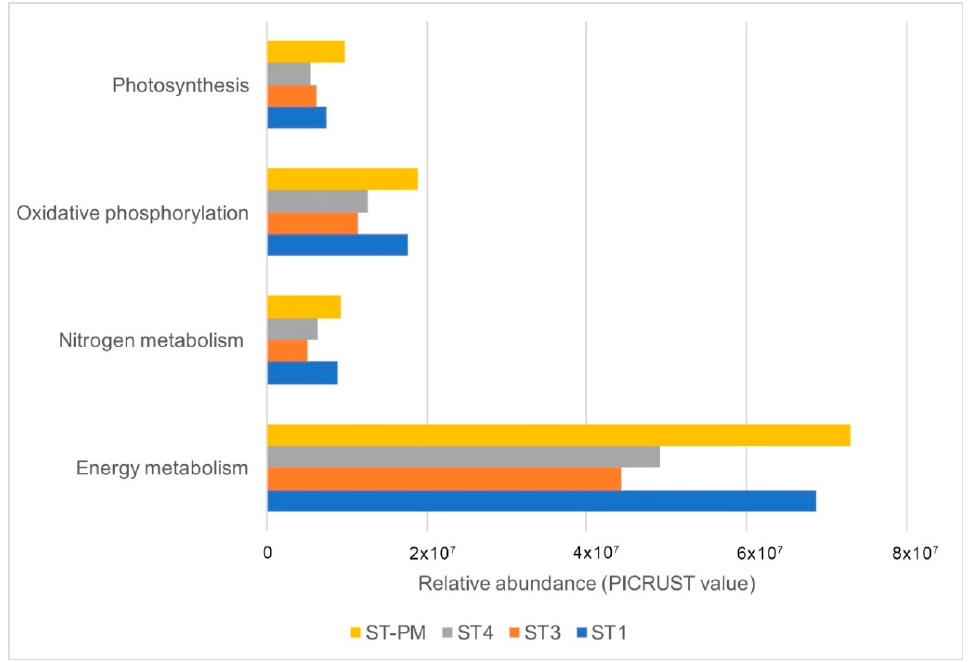
Figure 2. The relative abundance of predictive metagenome functions from samples. ST1, ST3, ST4: three water samples of L. vannamei; ST-PM: a water sample of P. monodon.